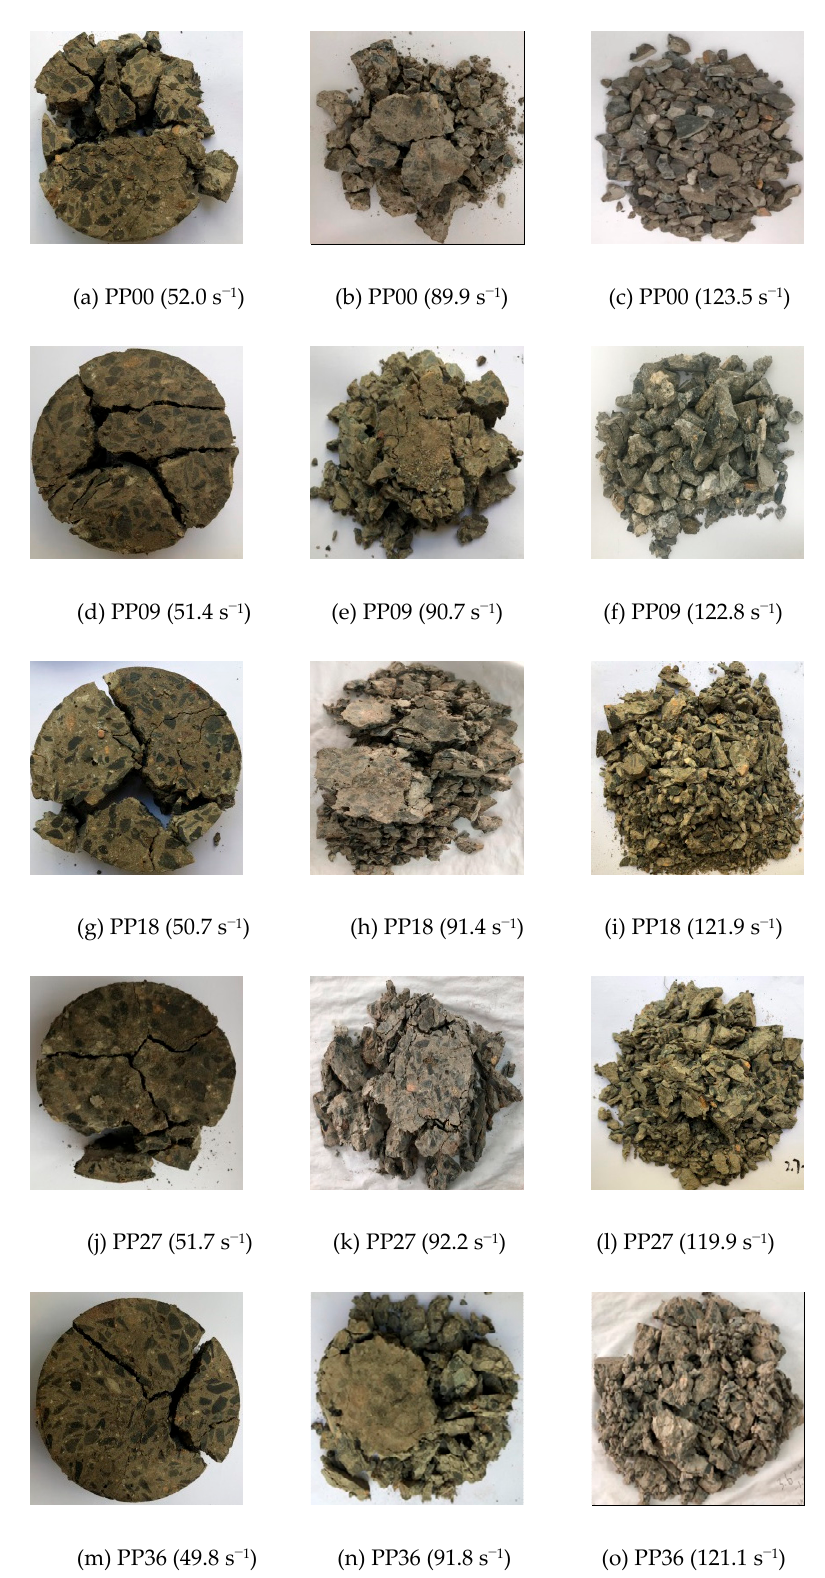
ff ects of strain rate and polypropylene fibre dosage on failure mode of all Figure 13. Effects of strain rate and polypropylene fibre dosage on failure mode of all mixtures. Figure 13. E